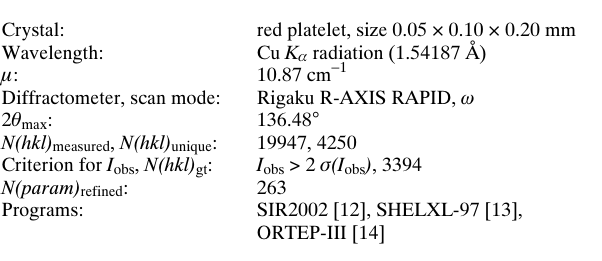
Table 1. Data collection and